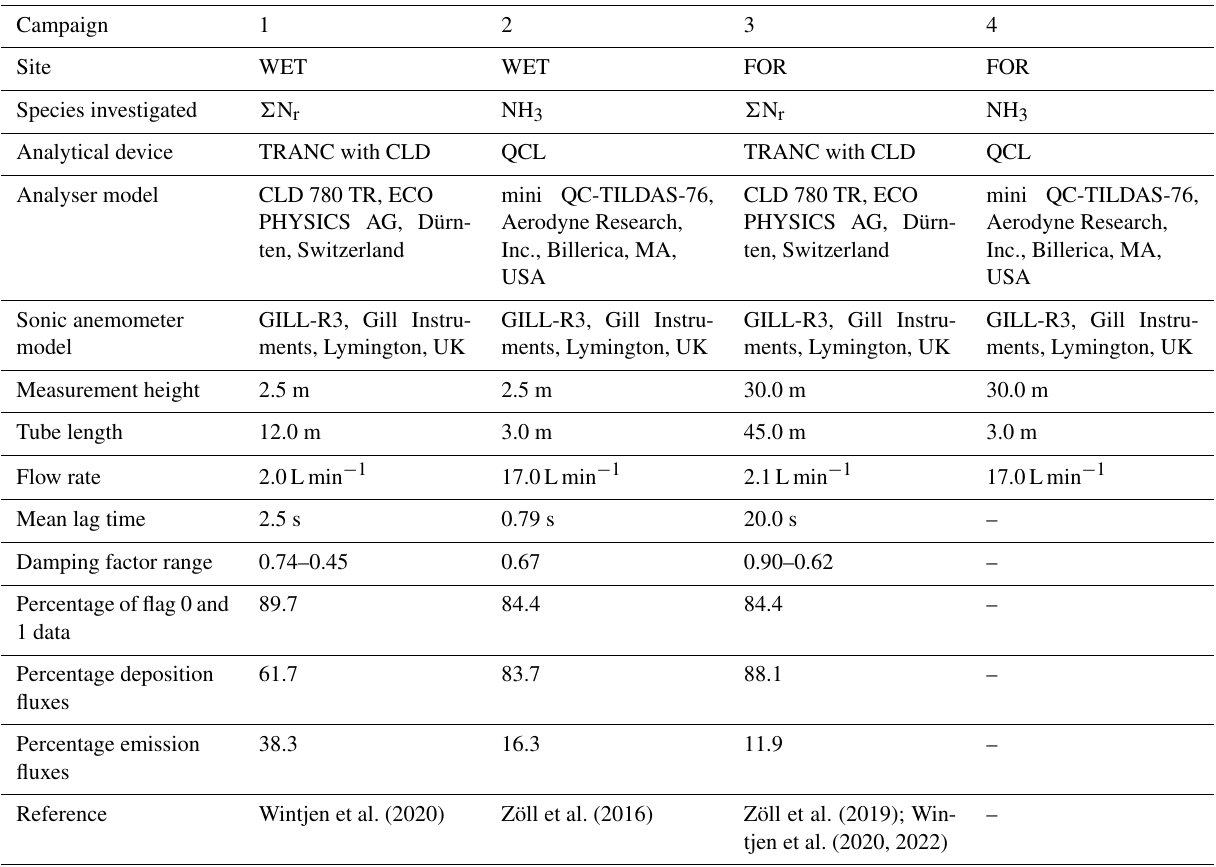
Table 2. Setups and data characteristics with (cid:54) N r referring to the sum of all reactive nitrogen compounds, with TRANC being the Total Reactive Atmospheric Nitrogen Converter, QCL being a quantum cascade laser spectrometer, and CLD being a chemiluminescence detector. Campaign 1 WET WET